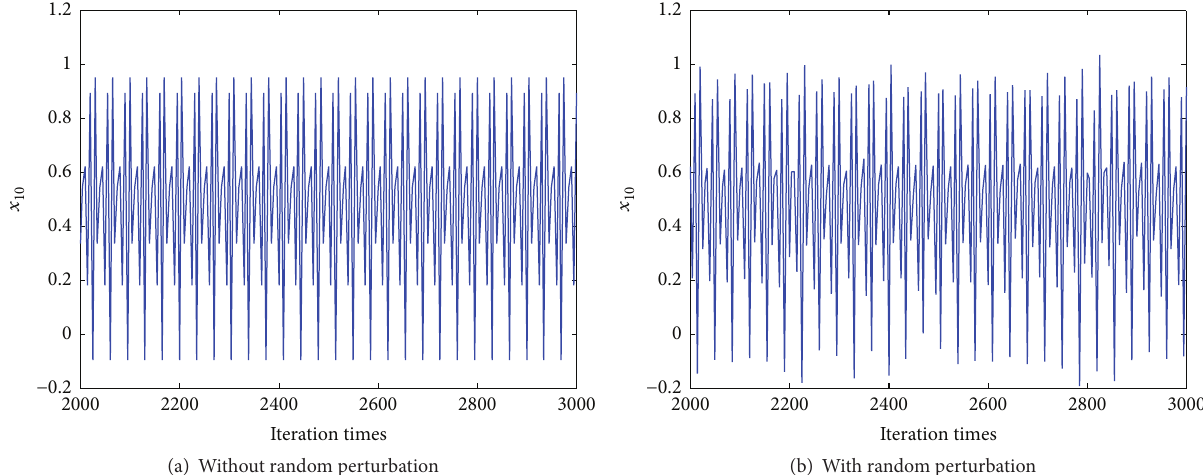
Figure 16: Time-process diagrams, 𝜔 = 175